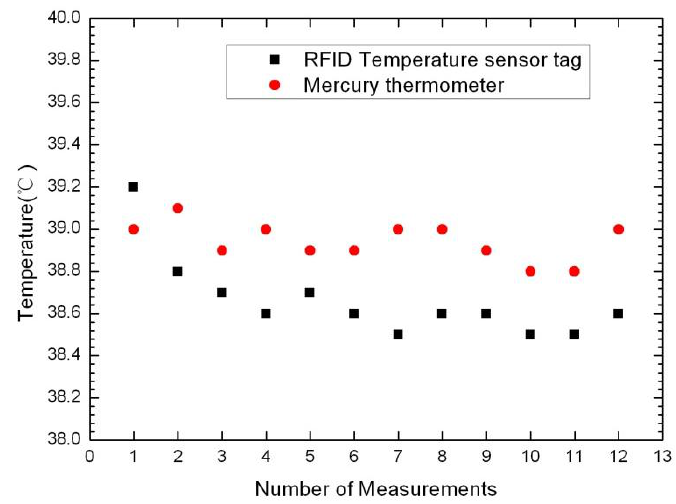
Figure 8. The data analysis results.